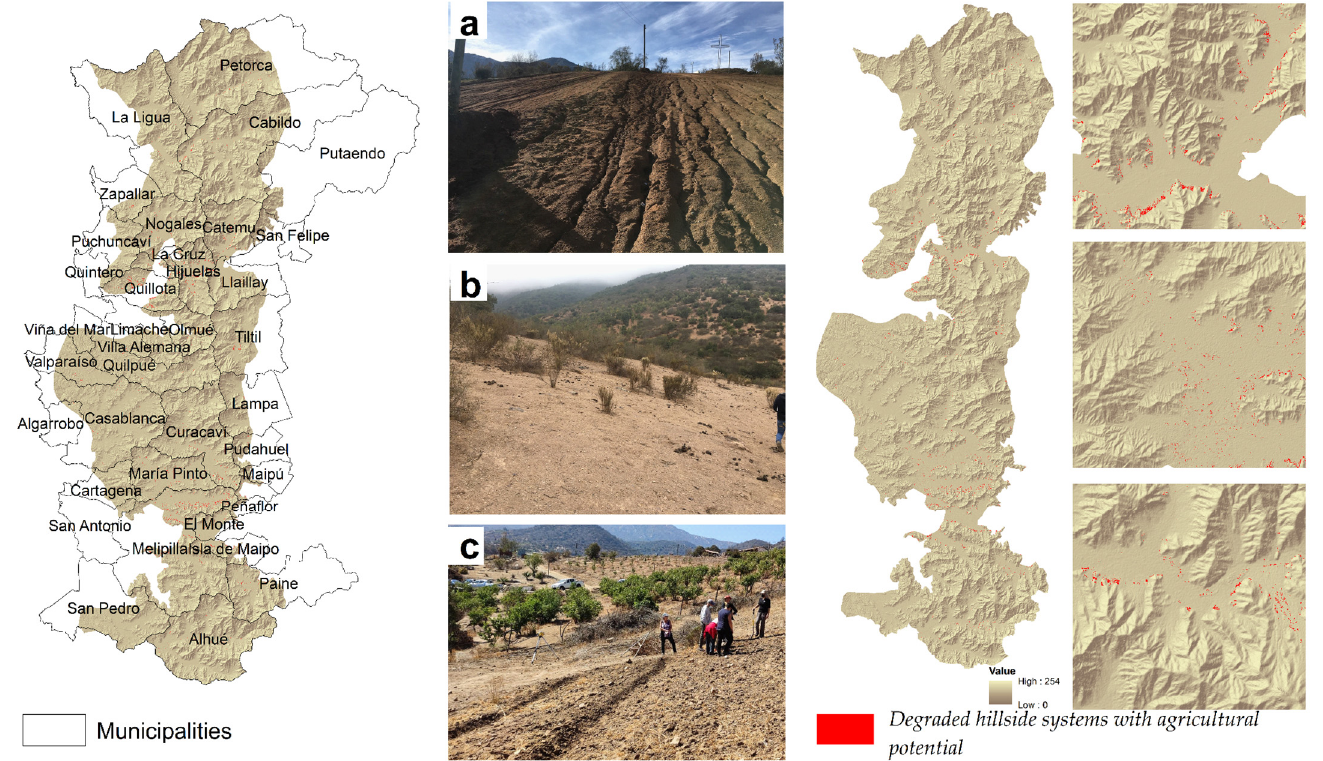
Figure 6. Spatial representation of the result of the integrated analysis of criteria to establish areas with potential for agricultural recovery or restoration, together with the communes belonging to the studied area. Photographs show: ( a ) hillside systems degraded by deforestation in Las Palmas (Olmue), ( b ) hillside systems degraded by agriculture and later abandoned (since 1982) in Roco (La Ligua), and ( c ) soil restoration activities applying the Keyline technique in Las Palmas (Olmue). In total, 37 communes (territorial municipalities) were present in the study area, 10 of which had areas greater than 100 ha (Figure 7). trative areas) that are present in the study area. In addition, images of degraded